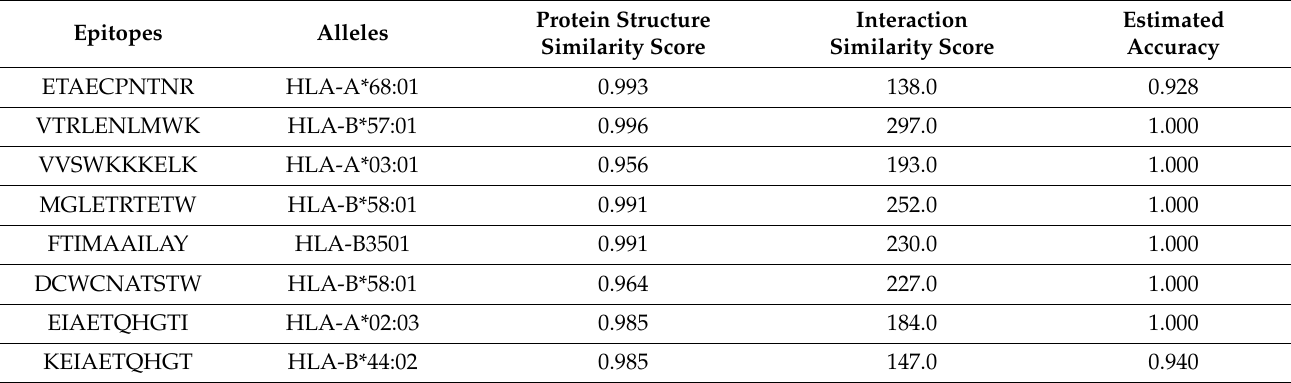
Table 5. Docking of selected CTL epitopes with their corresponding MHC-I